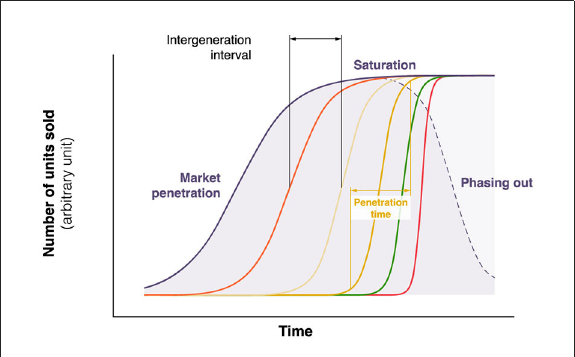
FIGURE3 Schematic illustration of the market penetration of various products (successive innovation cycles) as represented by their logistic curves. The figure exemplifies actual trends, i.e., the decrease in penetration time and intergeneration interval over